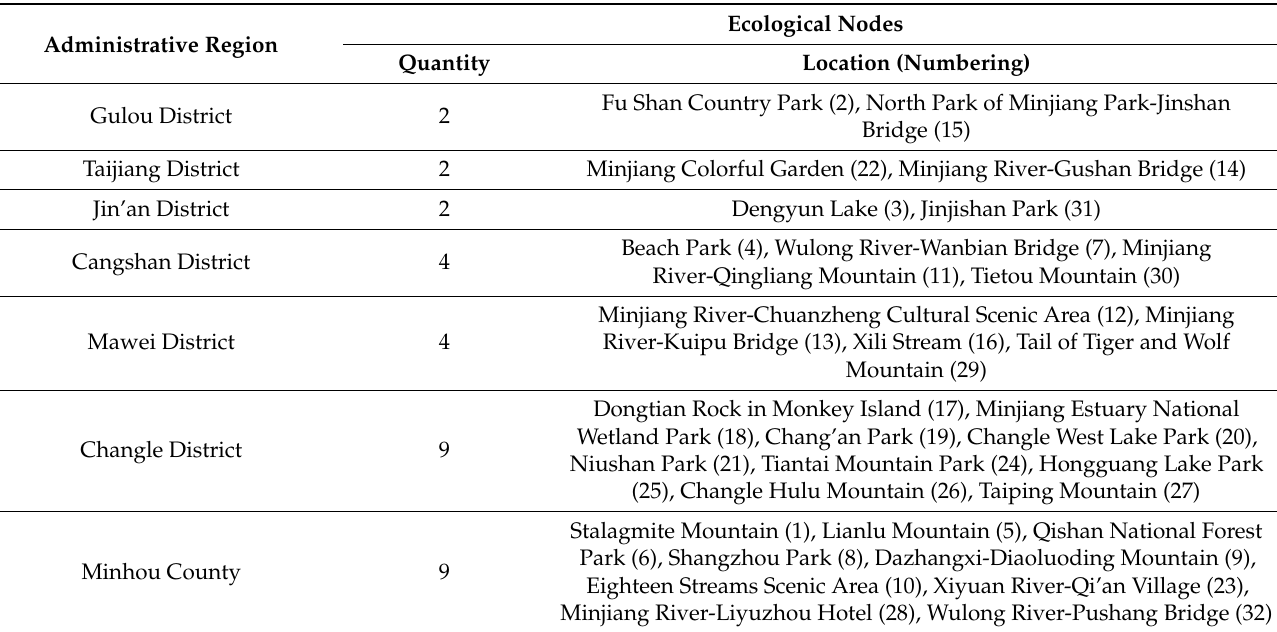
Table 3. Spatial distribution of the ecological